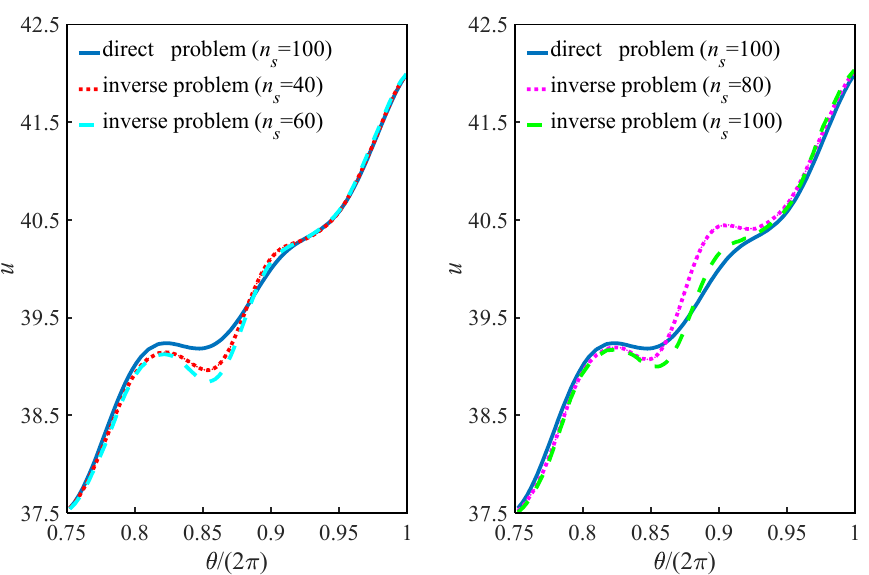
Γ . Figure 18. Comparison between u 2 in Step 2 (dashed lines) and u 2 in Step 1 (solid line) on Γ 2 . 2